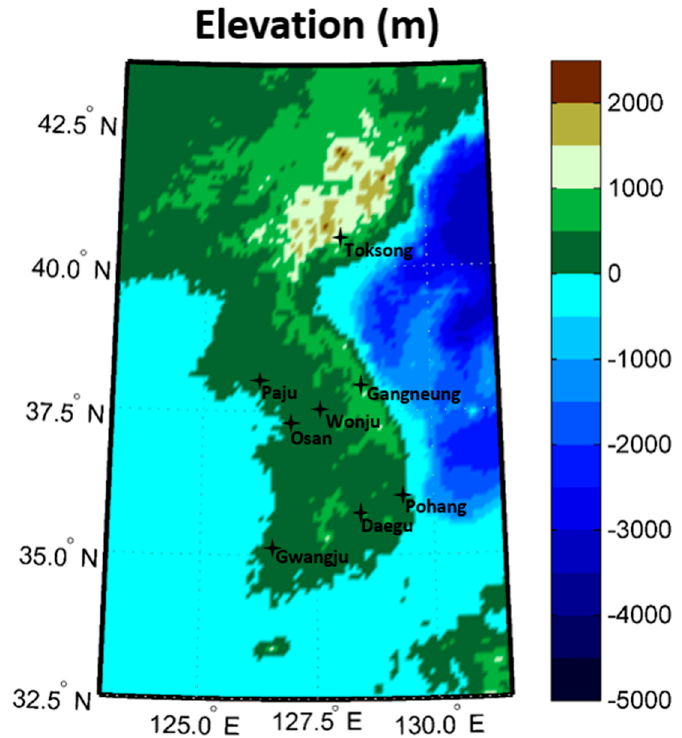
Figure 1. Topography of the Korean peninsula.